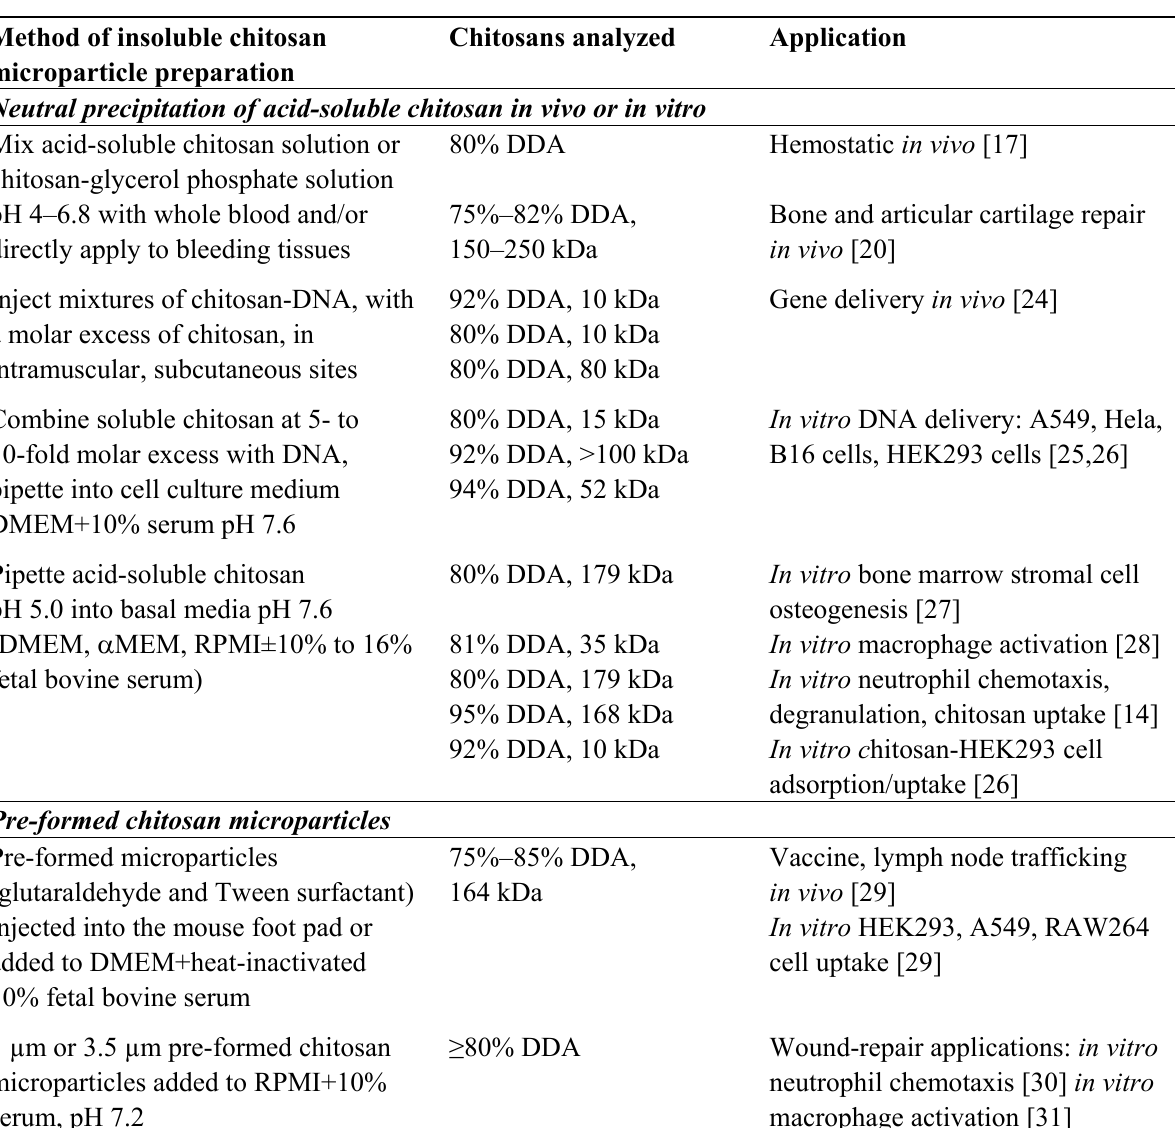
Table 1. Insoluble chitosan microparticles: Published examples of in vivo biomedical use, and in vitro investigation of cell